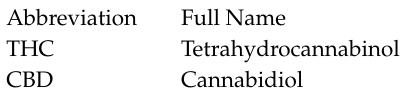
Table S1: de-identified data